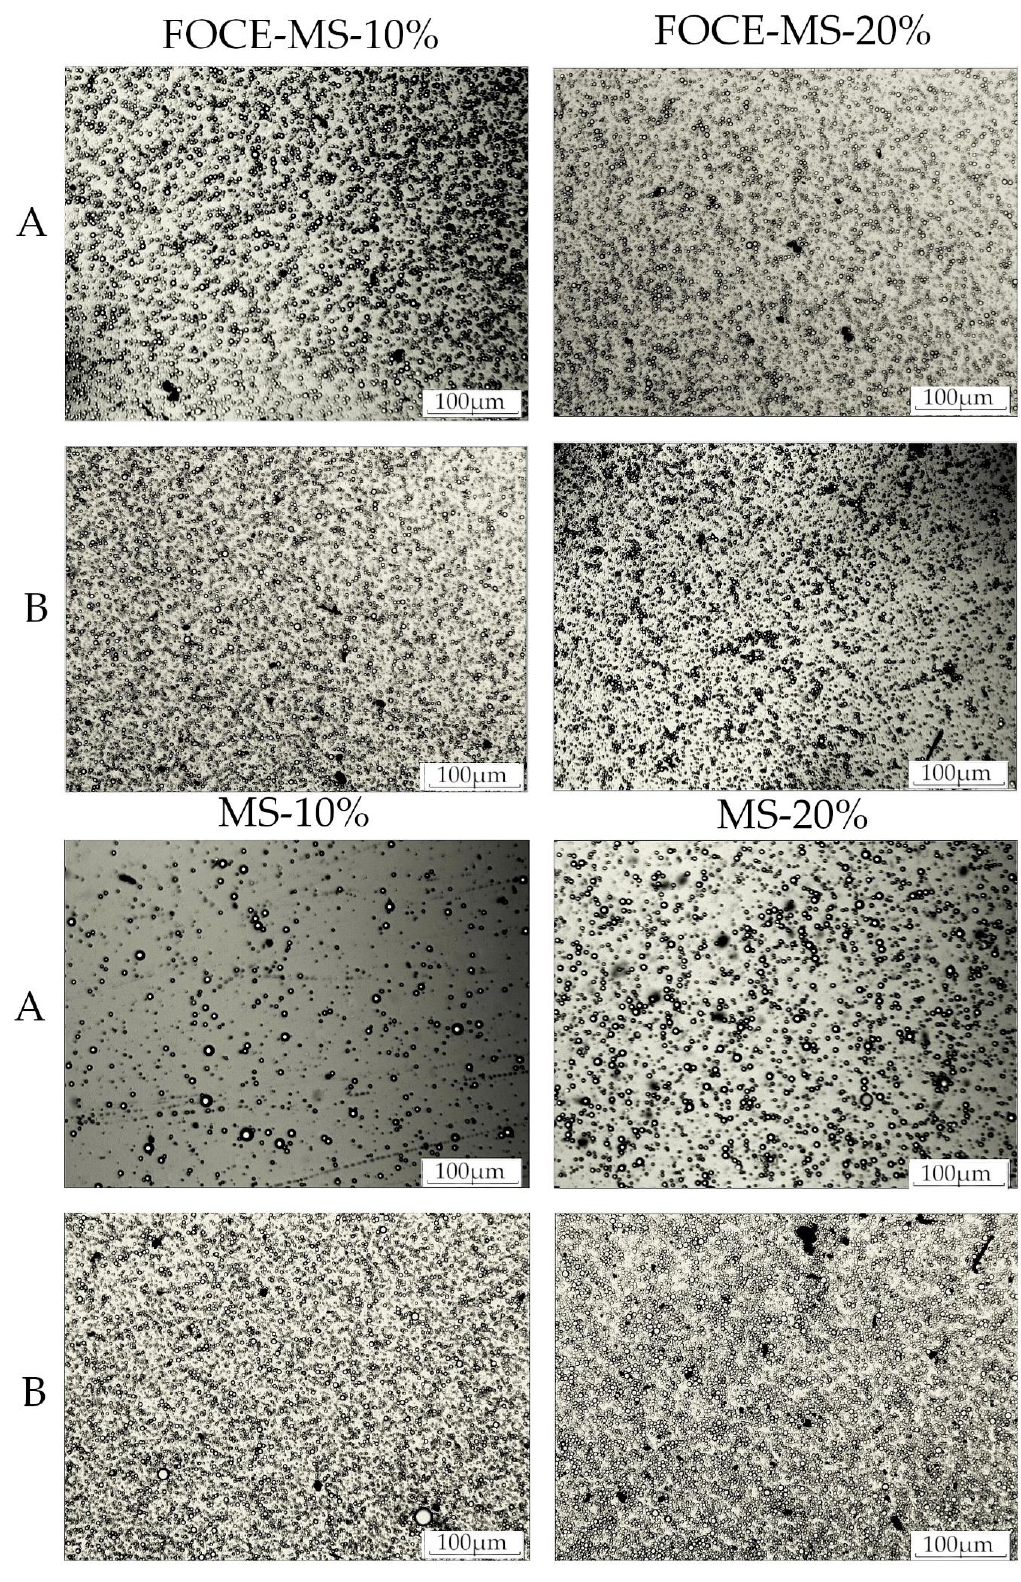
Figure 1. Optical microscopic images of emulsions ( × 10). A Samples before spray drying; and B samples after reconstitution. FOCE-MS-10%—FOCE-based emulsion with 10% of flaxseed oil; FOCE-MS-20%—FOCE-based emulsion with 20% of flaxseed oil; MS-10%—emulsion without FOCE with 10% of flaxseed oil; MS-20%—emulsion without FOCE with 20% of flaxseed